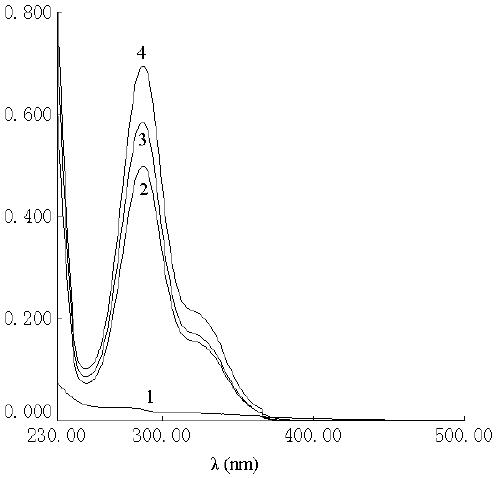
Figure 2. UV spectra of HP- β -CD ( 1 ), complex of naringenin and HP- β -CD ( 2 ), physical mixture of naringenin and HP- β -CD (3) and naringenin (4).